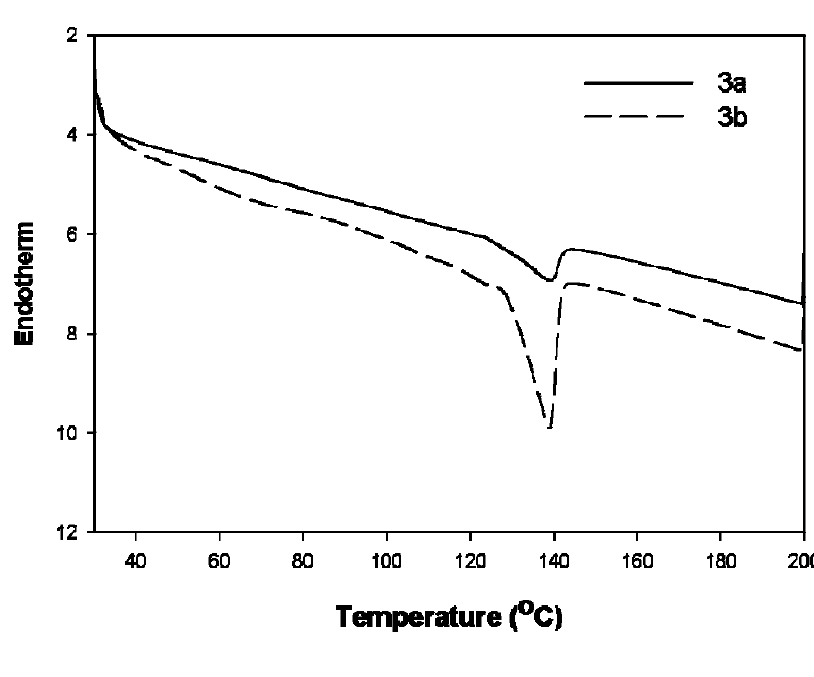
Figure 5. DSC curves of 3a and 3b